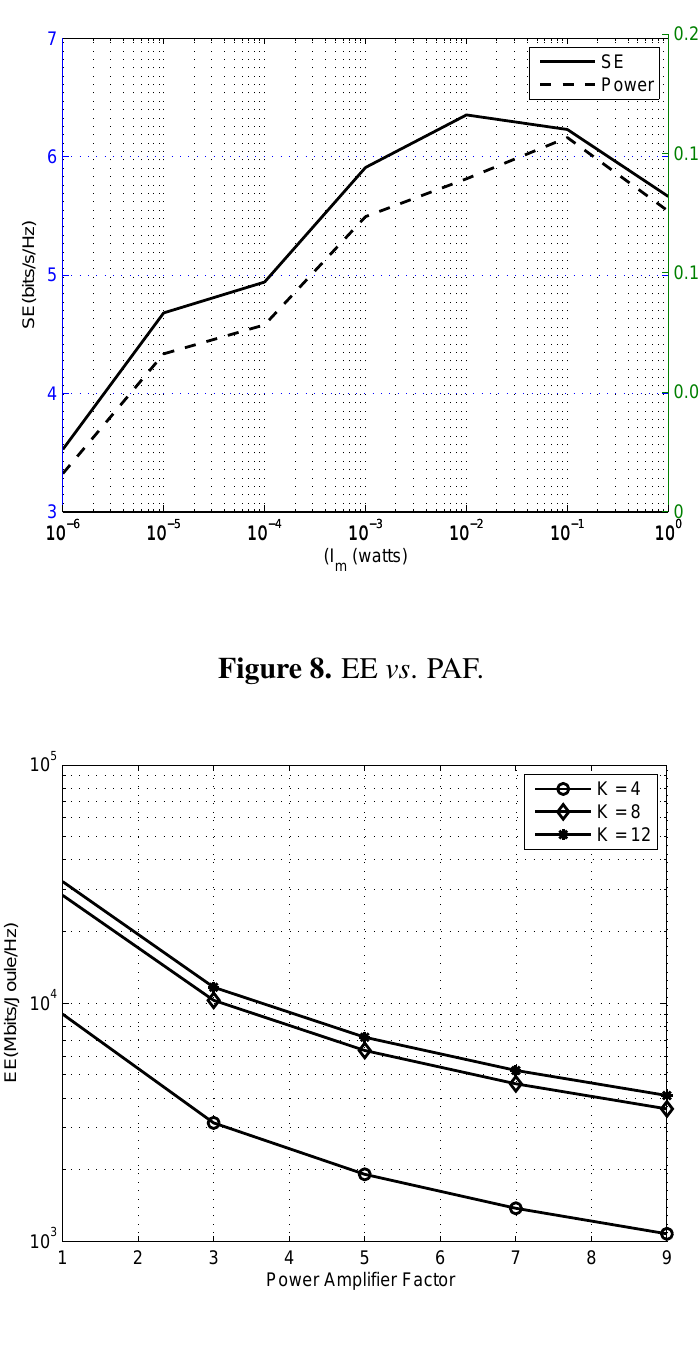
Figure 7. Spectral efficiency and total transmission power vs . interference threshold.